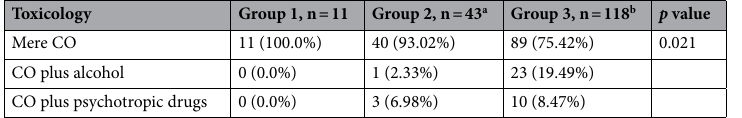
Table 5. Distribution of CO poisoning deaths by toxicology after exclusion of fire–related cases (n = 172). a 1 Case with combined alcohol and psychotropic drugs were repeatedly allocated to each category. b 4 Cases with combined alcohol and psychotropic drugs were repeatedly allocated to each